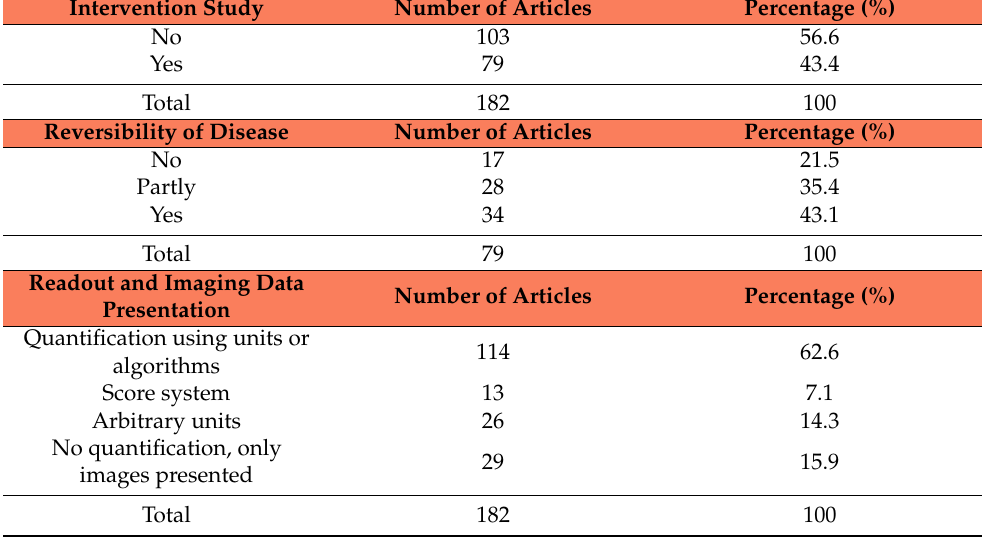
Table 4. Intervention and readout of the results from selected articles. Number of articles that included intervention in their studies and how many of those that showed reversibility of the lung injury. In addition, readout and the format in which the imaging data was presented, expressed either as quantified levels in unites, scoring systems, arbitrary units, or only shown as representative images.